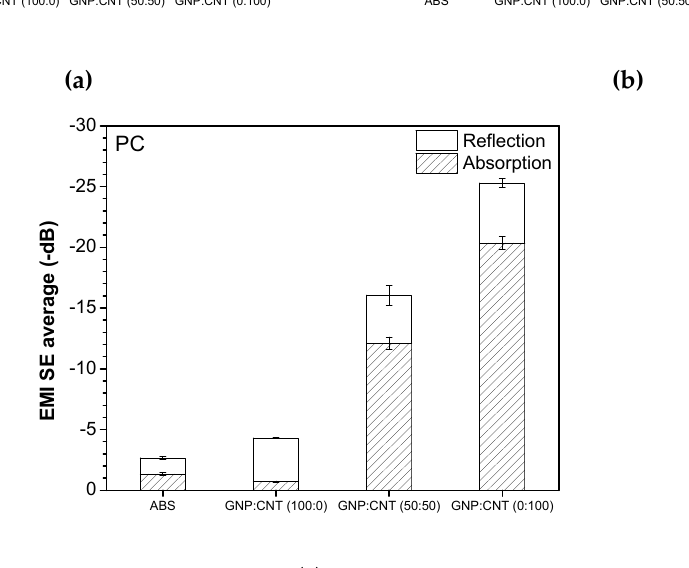
nanocomposites from FFF 3D printing: ( a ) HC, ( b ) H45, and ( c ) PC.